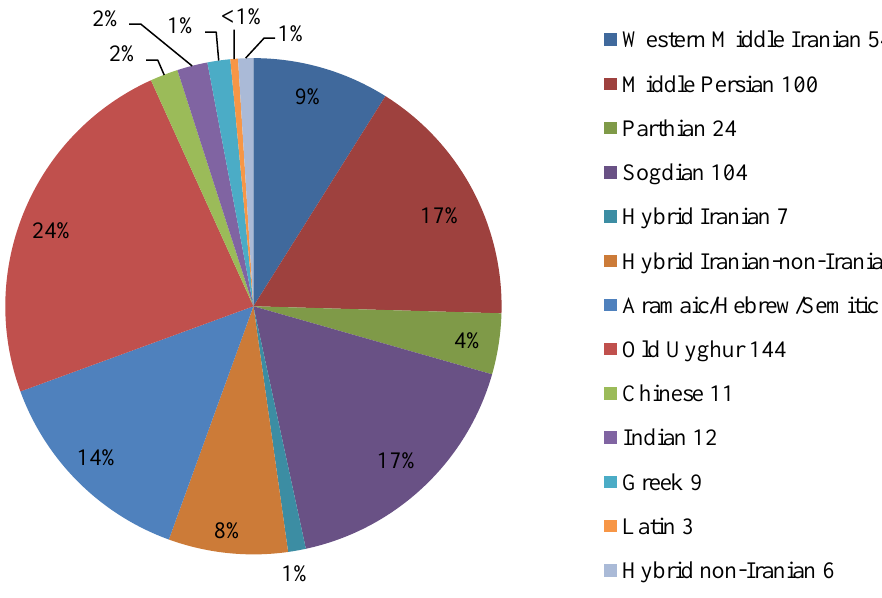
Figure 1 Linguistic origins of the names in the Iranian Manichaean corpus (languages arranged clock- wise in the diagram; percentage rounded; right side: total number of